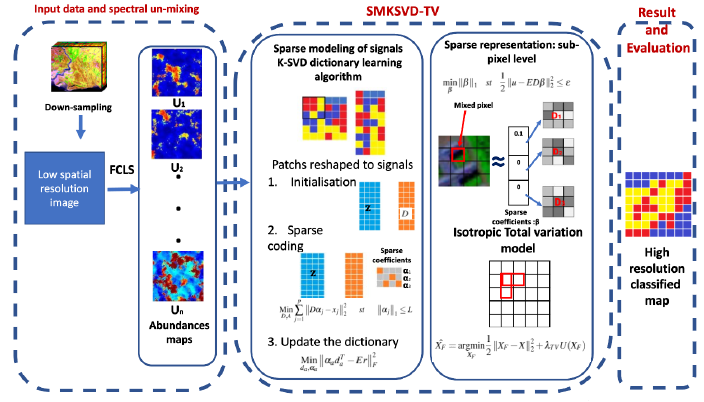
Figure 1. The proposed Sub-pixel Mapping method based on K-Single Value Decomposition dictio- nary learning algorithm and total variation minimization: